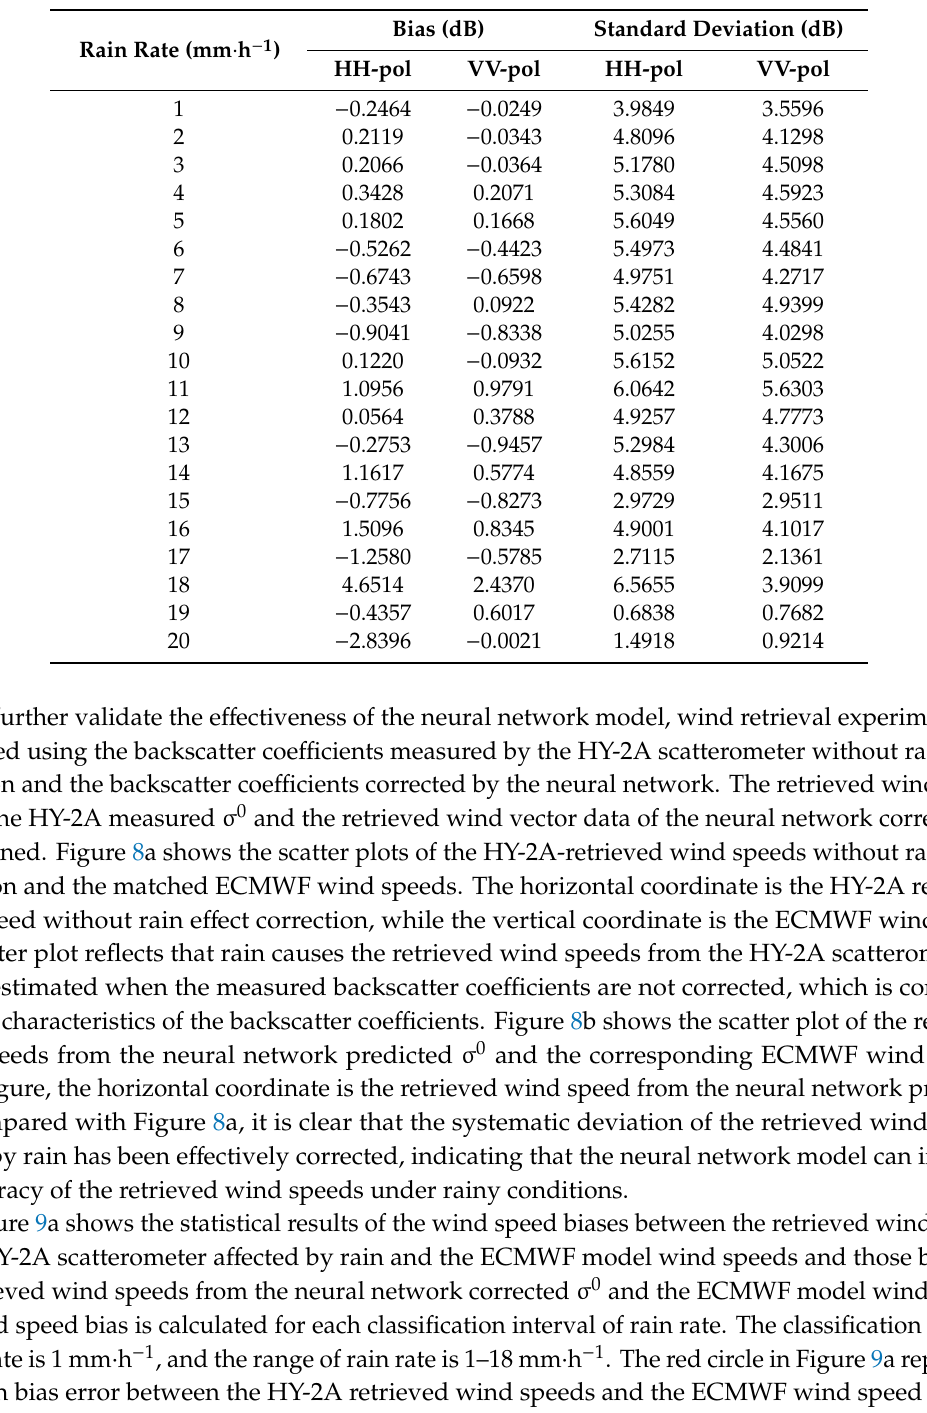
Table 4. NNW σ 0 and ECMWF model σ 0 statistical